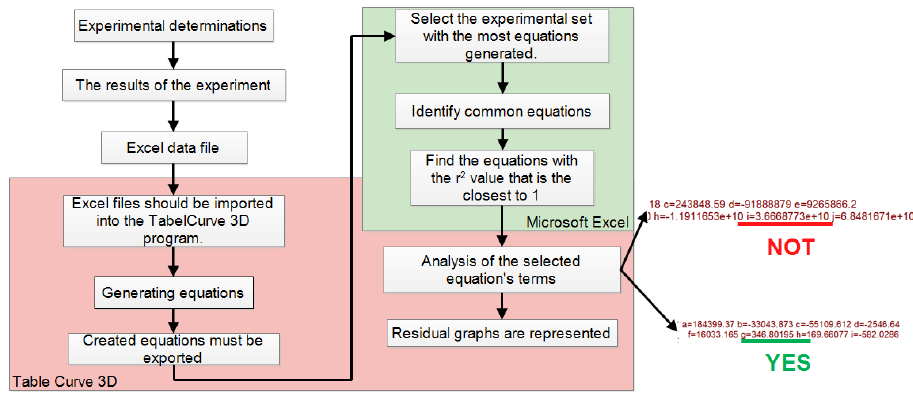
Figure 4. The steps involved in creating a mathematical equation.